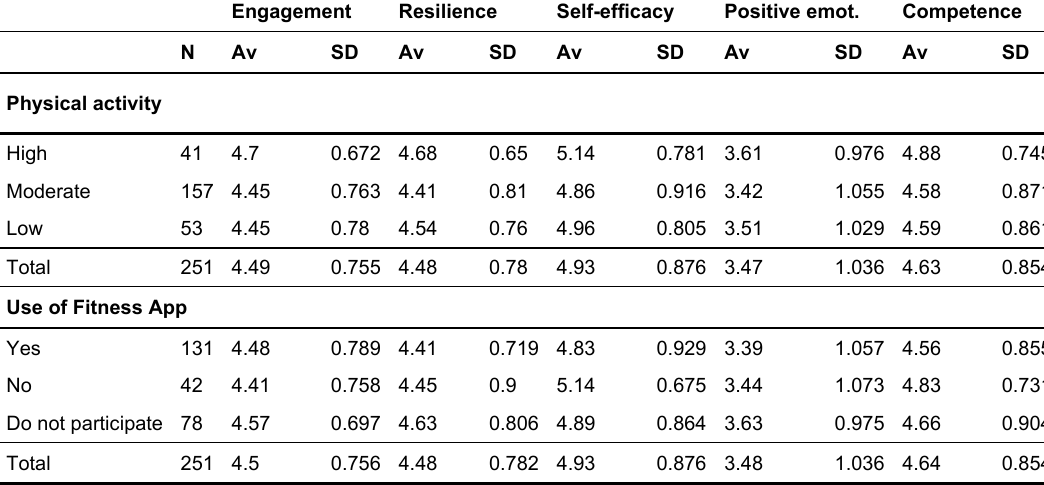
Table 3. Healthy employee according to Physical activity levels and use of the Fitness App.